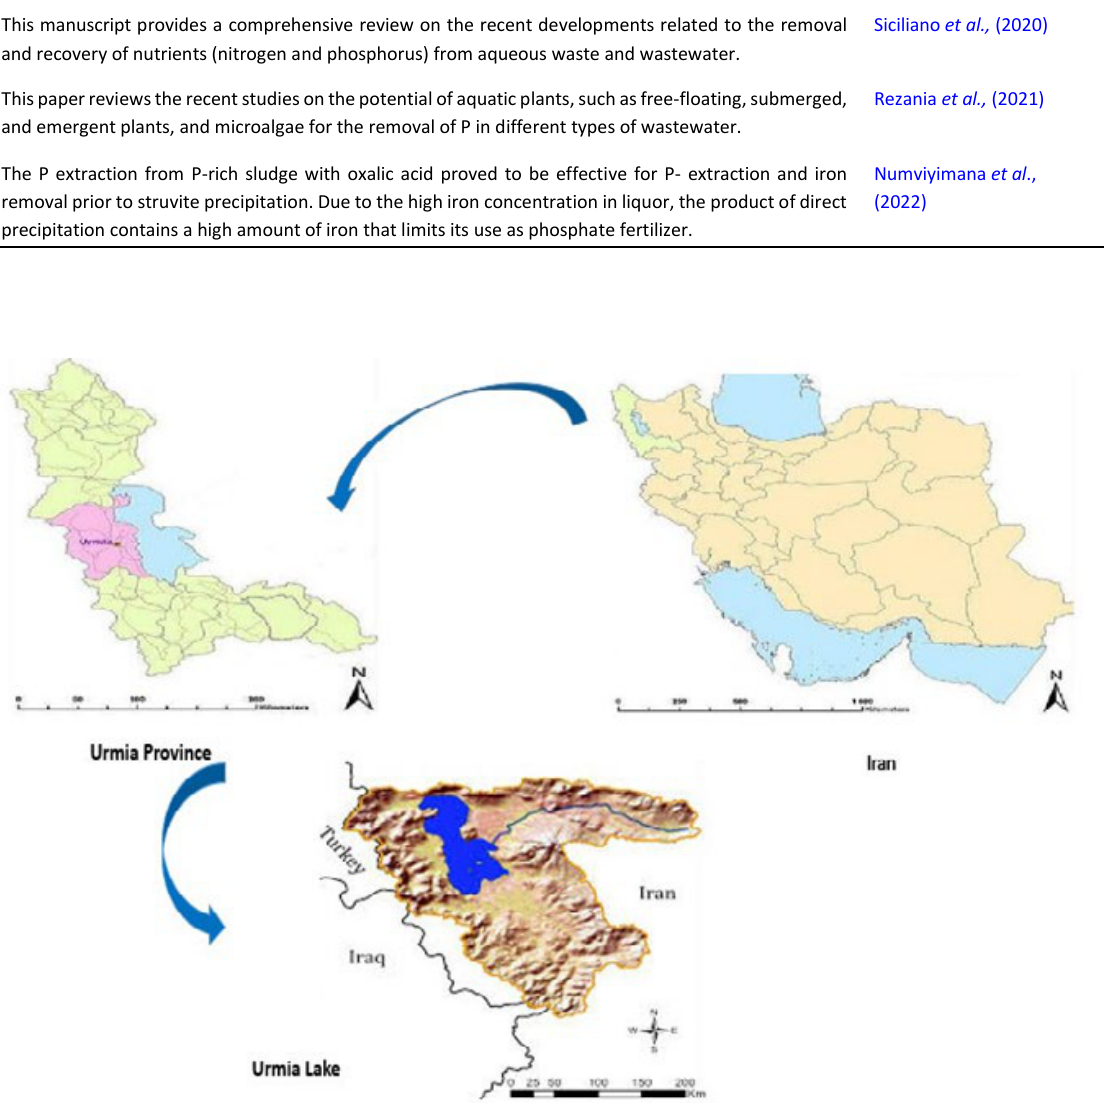
Fig. 1: Geographic location of the study area in Urmia, West Azerbaijan province, Iran